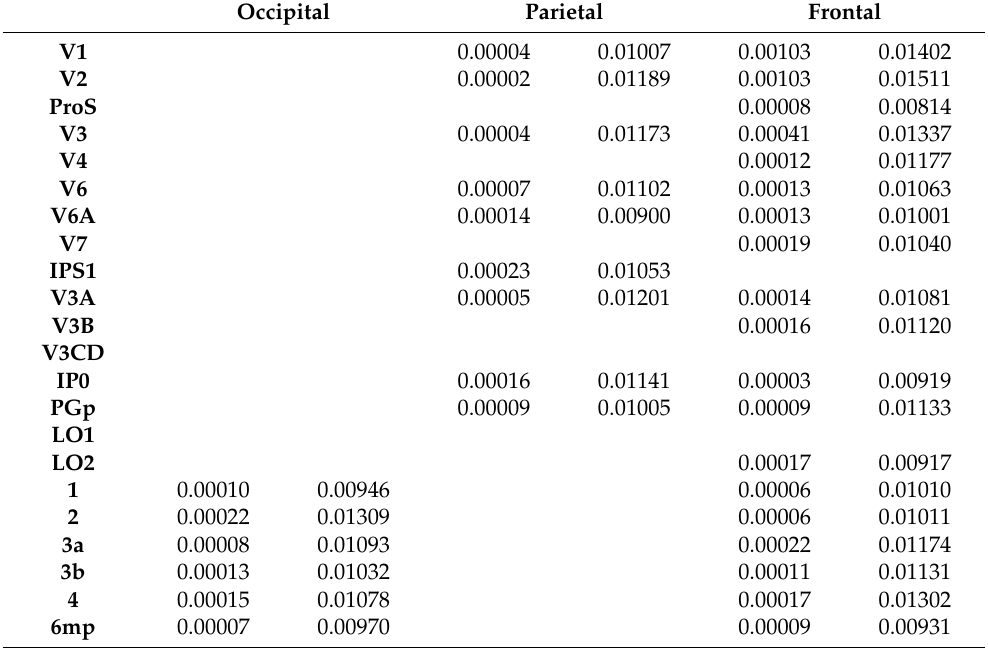
Table 3. Connectivity values for all ROIS towards each of the three sectors. Values of Γ ( r a , b ) and ∆ ( r , B ) computed from WPLI are